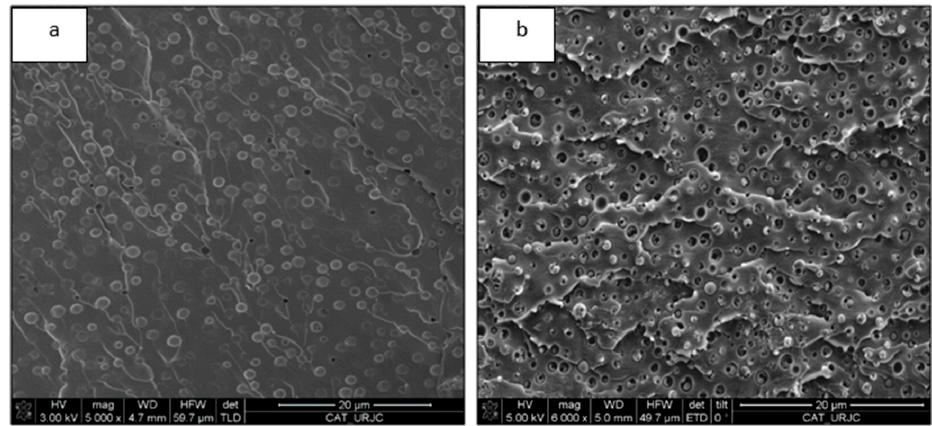
Figure 6. FEG-SEM micrographs of epoxy blends with 15% PCL: PCL/TETA/DGEBA ( a ) and PCL/DDS/DGEBA ( b ).